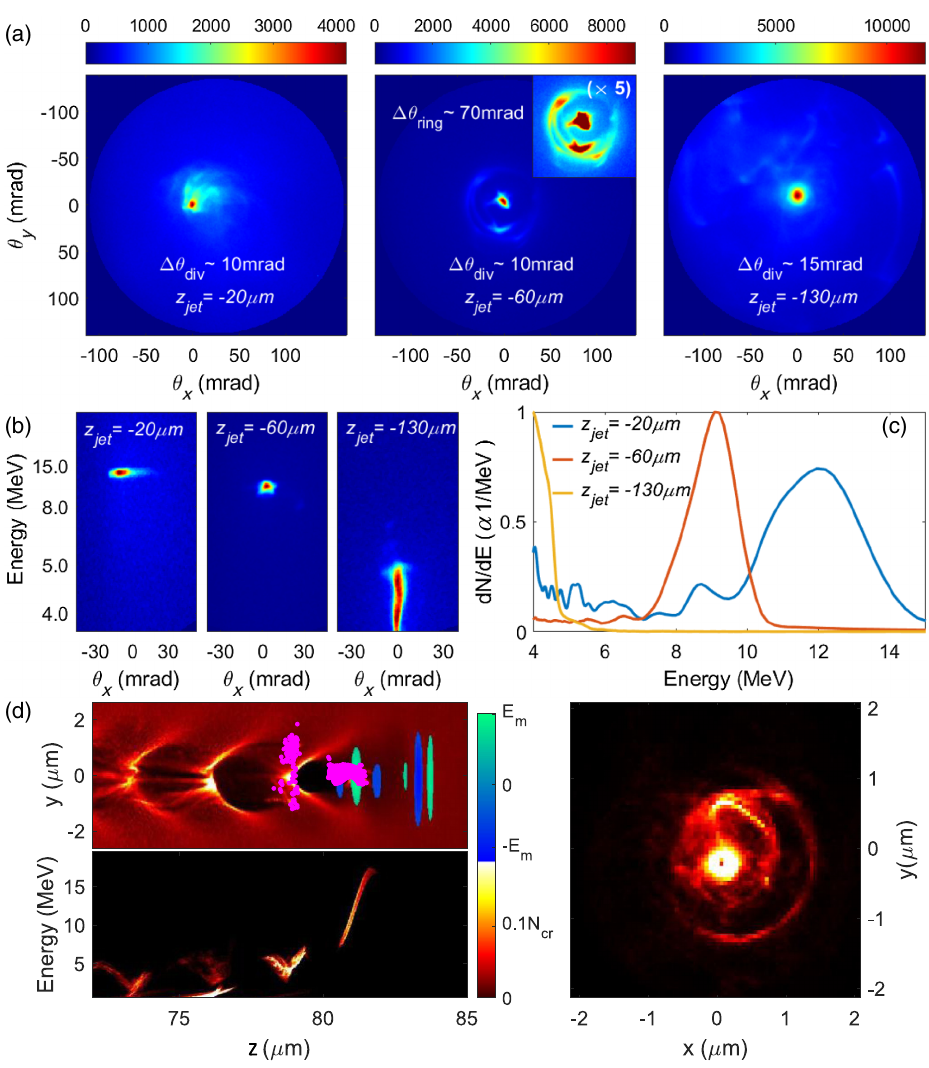
0 . 10 , ð P=P ∼ 3 . 1 . =N e; peak cr ¼ cr Þ max − 60 μ m (near half-peak density in the . The middle panel inset for z jet jet ¼